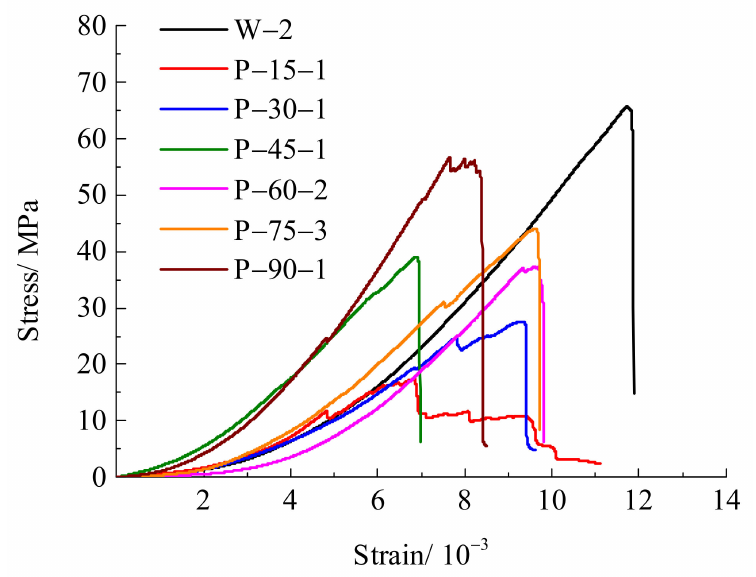
Figure 5. Stress–strain curves of the limestone specimens with prefabricated cracks.